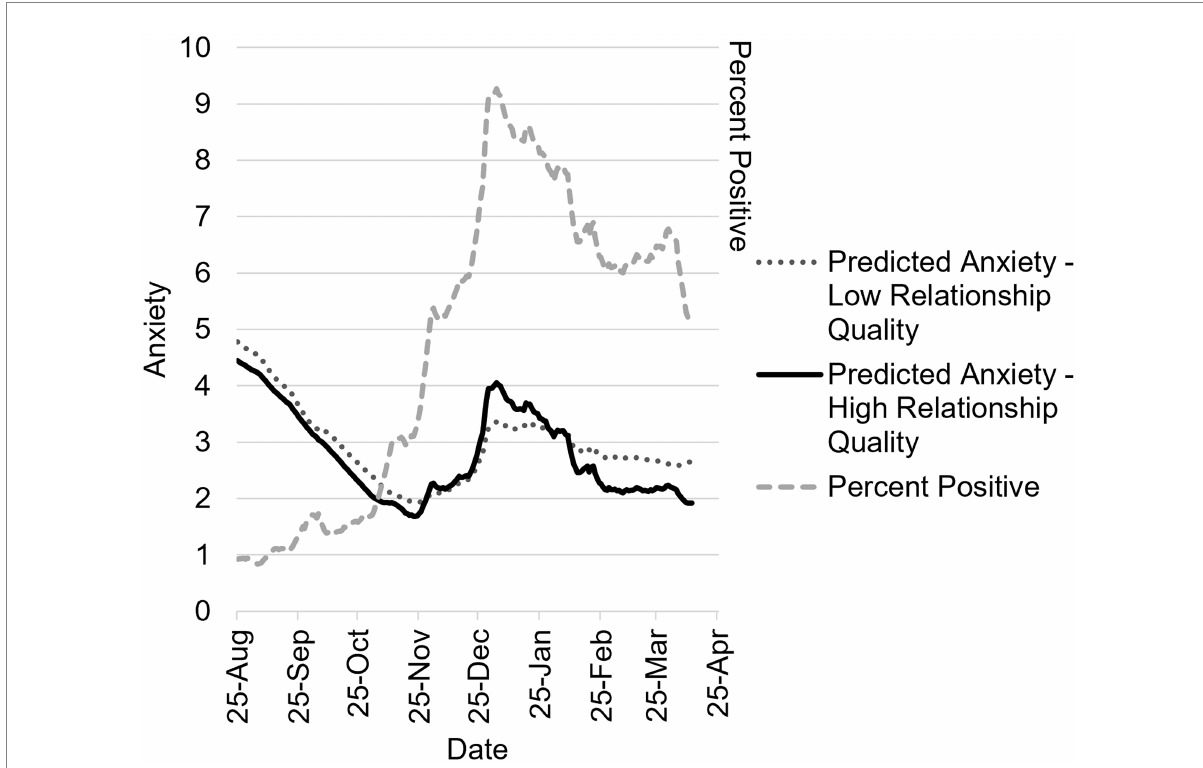
FIGURE 2 Two-way interaction model predicting daily anxiety between August 2020–April 2021 as a function of COVID-19 percent positivity testing rate, season, and relationship quality. Predicted daily anxiety in individuals with low-quality ( − 1 SD ) and high-quality (45, maximum score, since +1 SD was slightly outside the range of the scale) relationships as a function of daily percent positive testing rate in NYC and season. Anxiety scores can range from 1 to 9, and percent positive can range from 0 to 100, but the range of percent positive was 0.84 to 9.14 during the observation period. The jagged shape of the graph comes from modeling the effect of actual reported citywide seven-day percent positivity